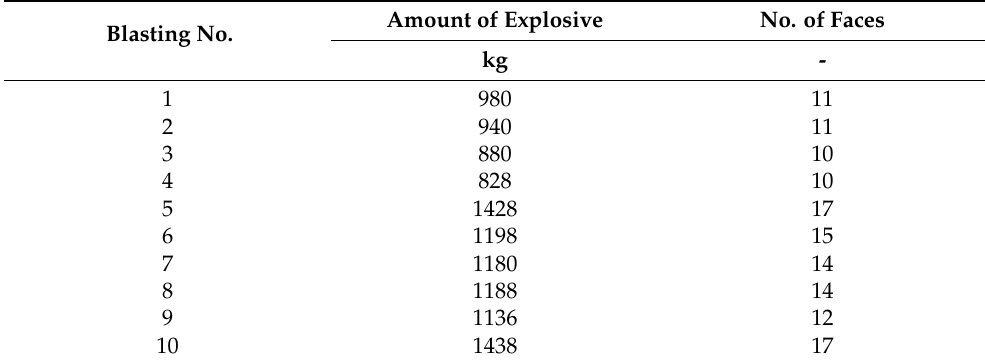
Table 4. Details of analyzed group blasting.